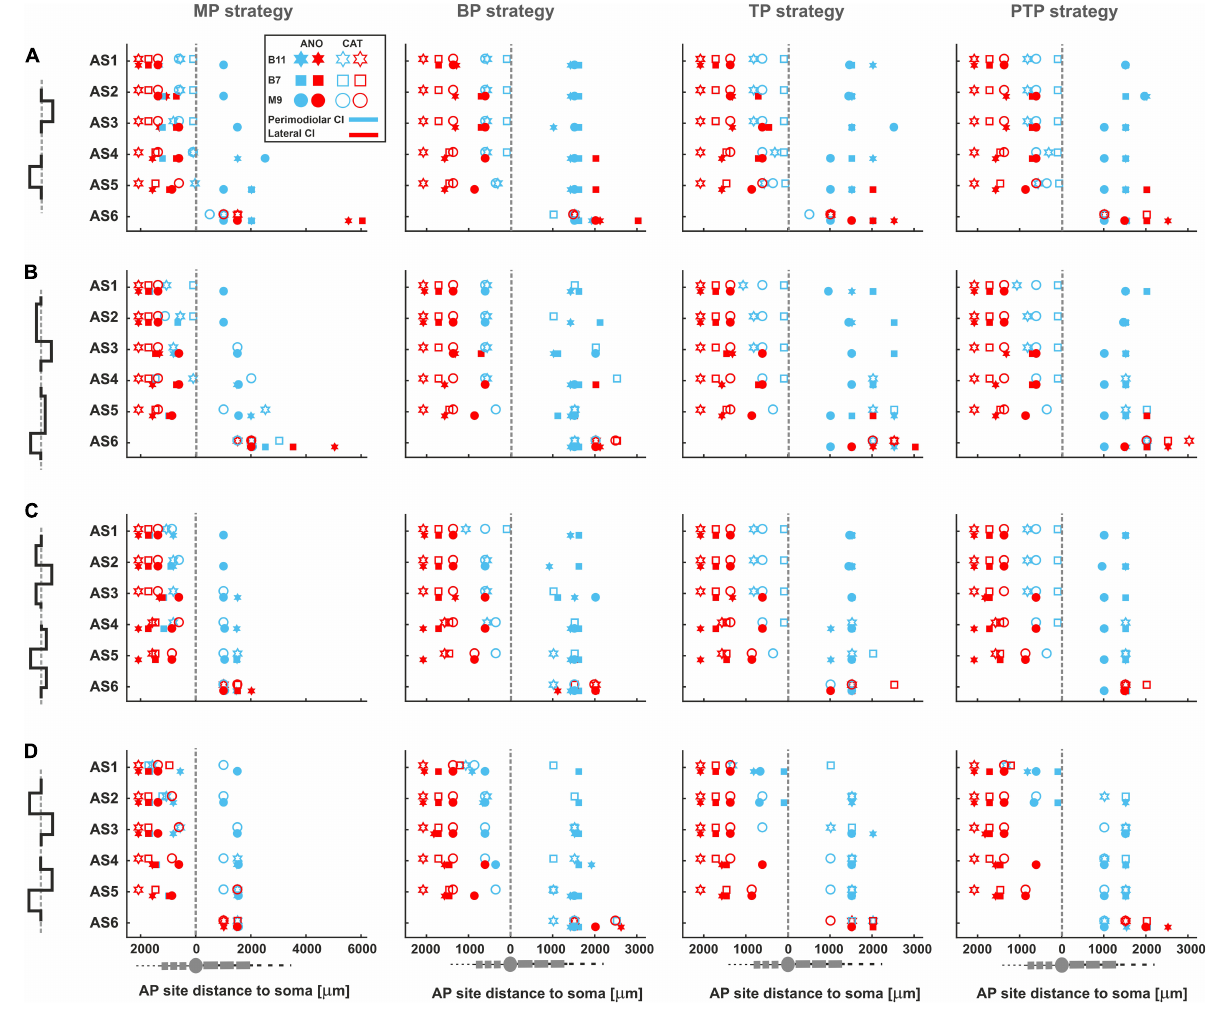
polarity effect is lost, similar as in Figures 10B–D , right